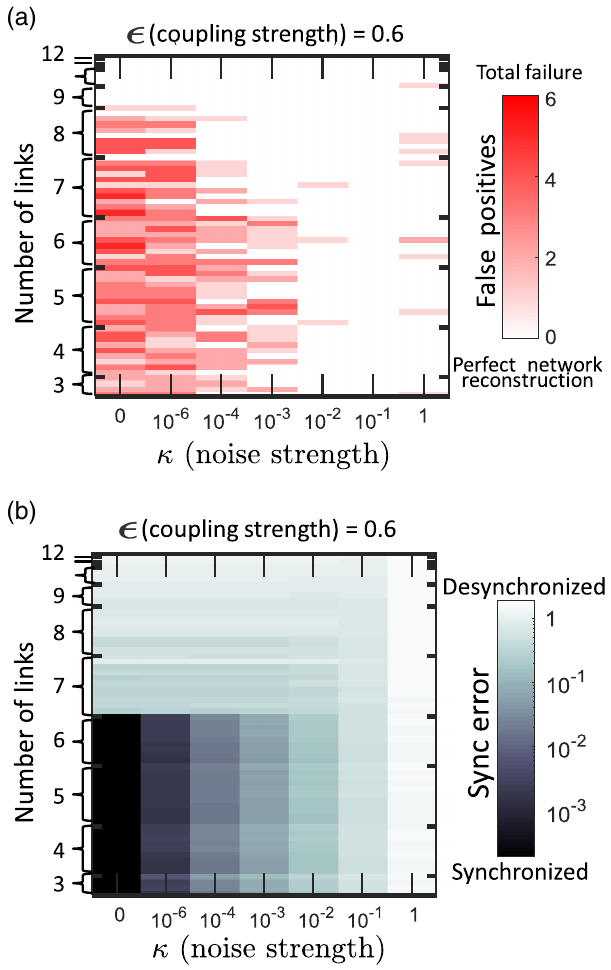
FIG. 6. Simulation test results with varying noise strength κ . (a) Number of false positives and (b) synchronization error for simulated time series from different networks with progressively increasing noise. As described in the text, each horizontal cut of the plots represents a single trajectory of the system, starting from a random initial condition. The convention for the sequence of the networks is the same as in Fig.